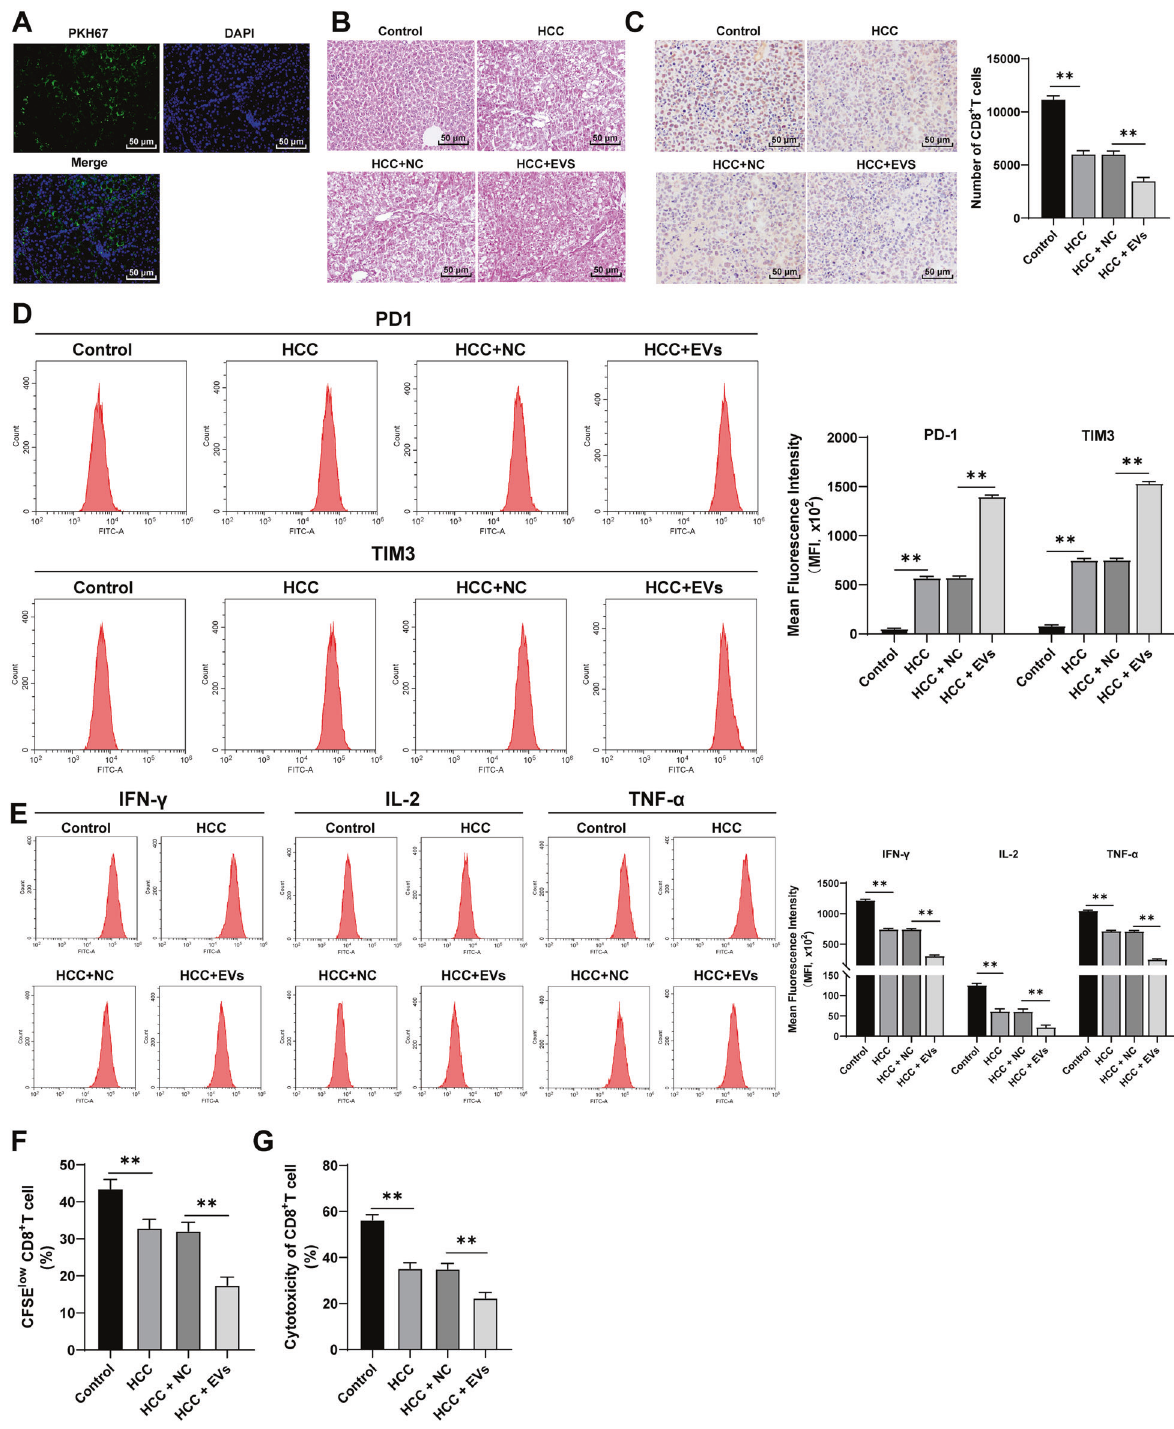
Fig. 1 M2 macrophage-derived EVs promoted CD8 + T cell exhaustion in mice with primary HCC. The murine model of primary HCC was established by DEN/CCl 4 combined induction, and the model mice were injected with EVs via tail vein. A The absorption of EVs by mouse liver tissues was detected using immuno fl uorescence. Green indicated PKH67-labeled EVs and blue indicated nuclear staining. B Histopathological changes of liver tissues were observed using HE staining at the 40 th week after induction. C The number of CD8 + T cells in tumor sections was detected using immunohistochemistry. PBMCs were isolated from the mouse liver and CD8 + T cells were sorted. D The expressions of immune checkpoint inhibitory receptors (PD1 and TIM3) on CD8 + T cells were detected using fl ow cytometry. E The expressions of effector cytokines (IFN- γ , IL-2, and TNF- α ) were detected using fl ow cytometry. F The proliferation ability of CD8 + T cells was measured using fl ow cytometry. G The ability of CD8 + T cells to kill Hep1-6 cells was measured using fl ow cytometry. N = 6. The cell experiment was repeated 3 times. Data are presented as mean ± standard deviation and analyzed using one-way ANOVA, followed by Tukey ’ s multiple comparison test, ** p <